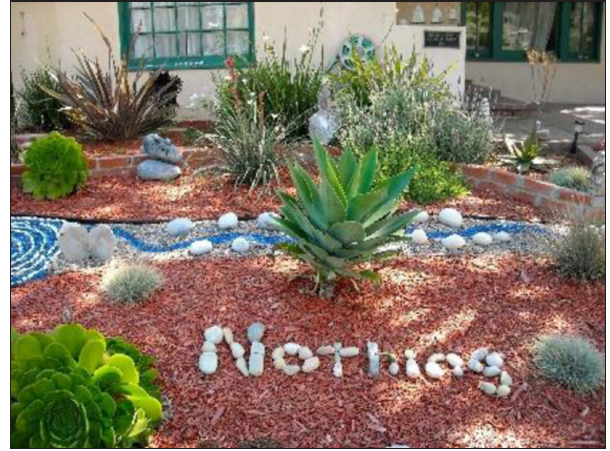
Figure 1: Nothing is written in stone. Photo: Paul Harris.